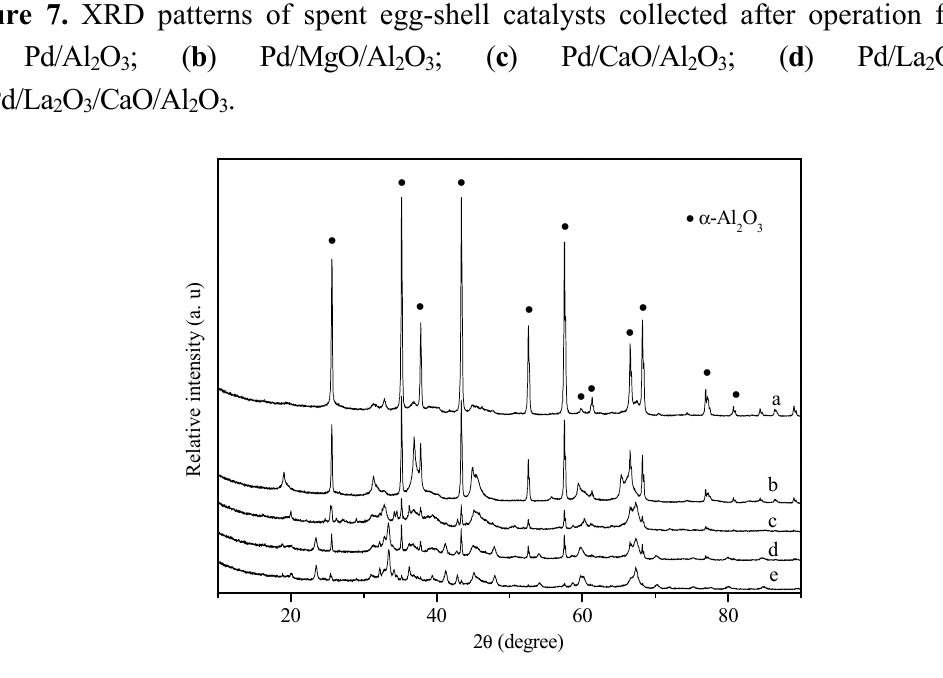
Figure 7. XRD patterns of spent egg-shell catalysts collected after operation for 10